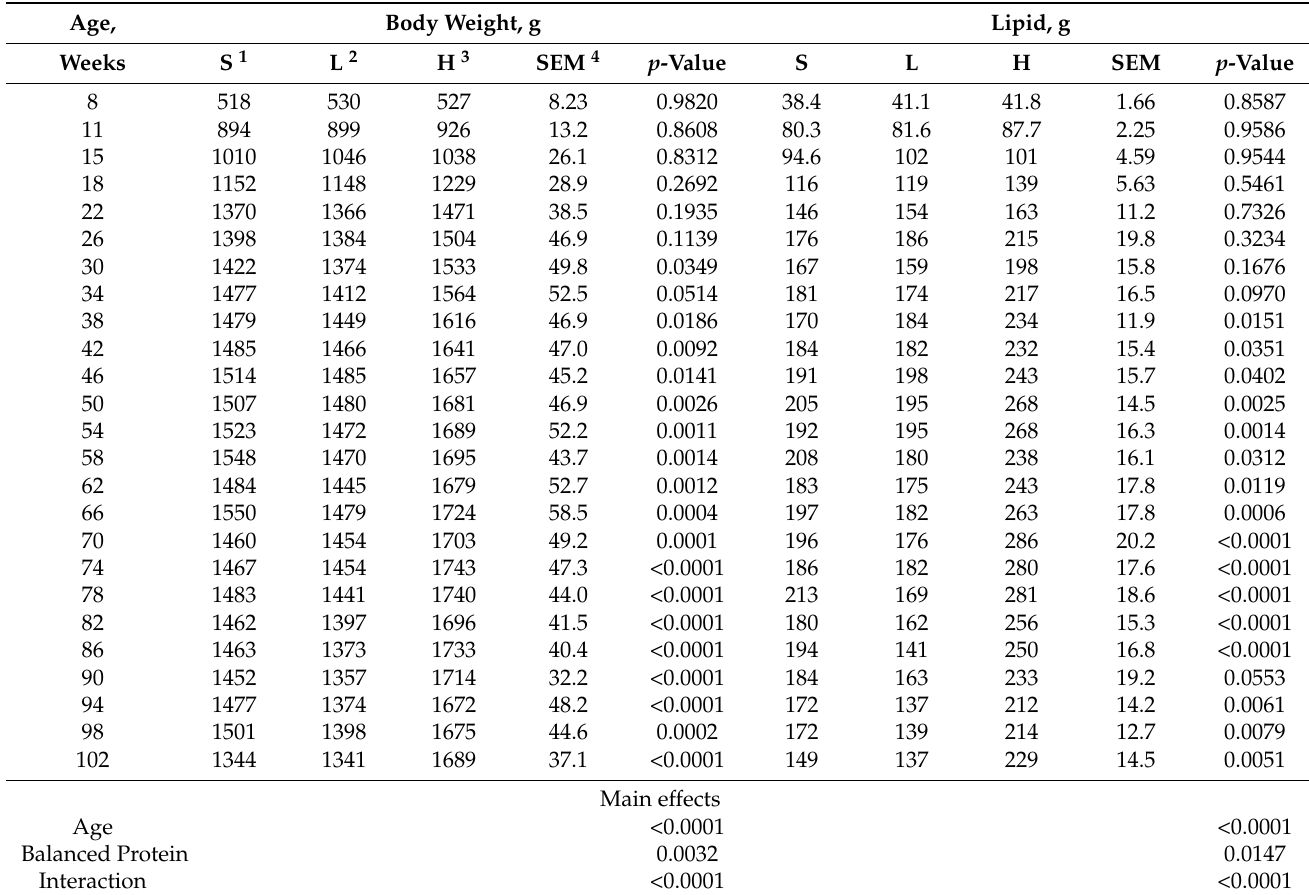
Table 6. Body weight and body lipid of laying hens from 8 to 102 weeks old in response to three dietary balanced protein feeds.